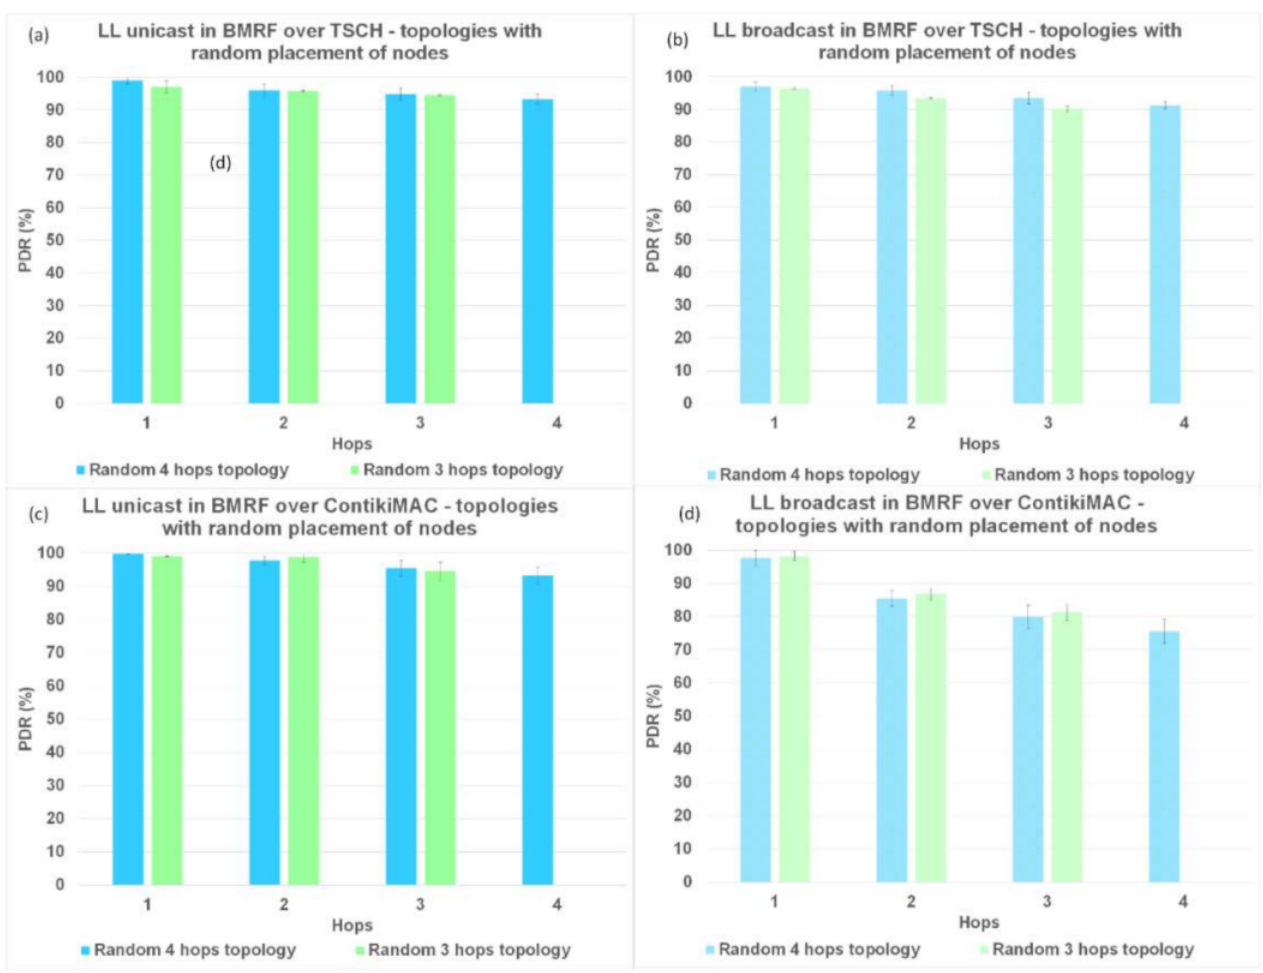
Figure 10. PDR comparison between LL unicast and LL broadcast and between ContikiMAC and TSCH on topologies with a random placement of nodes. ( a ) Results for LL unicast in BMRF over TSCH. ( b ) Results for LL broadcast in BMRF over TSCH. ( c ) Results for LL unicast in BMRF over ContikiMAC ( d ) Results for LL broadcast in BMRF over